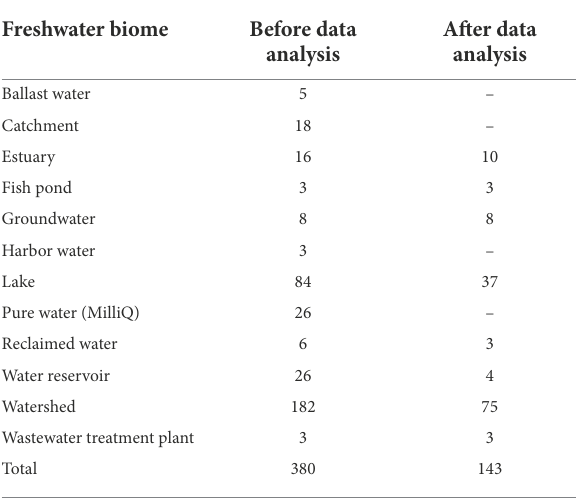
TABLE 1 Freshwater biomes of the metagenomes used in this